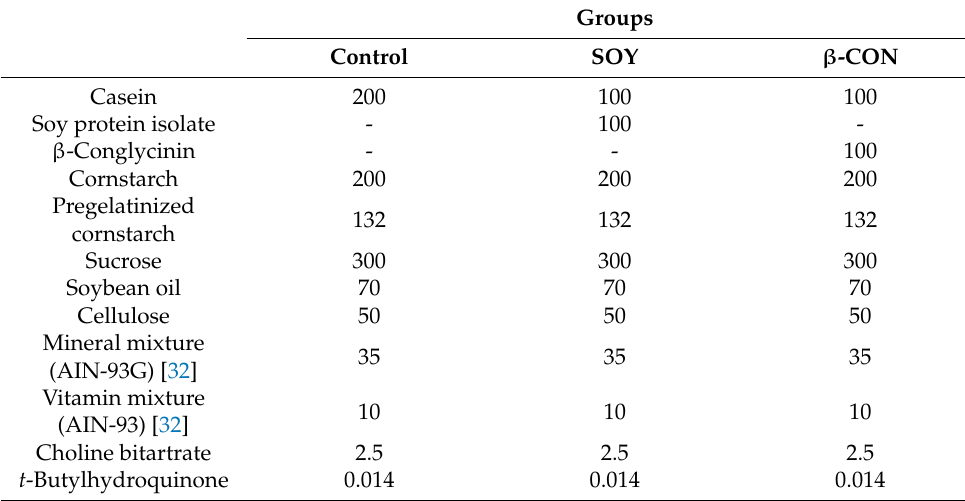
Table 5. Diet composition (g/kg